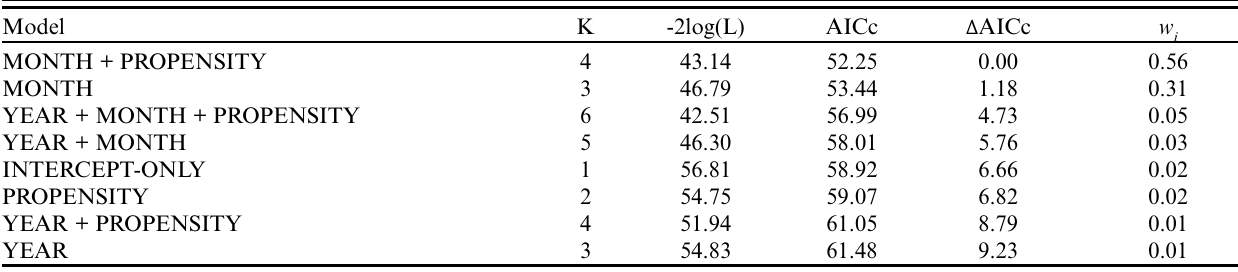
Table 5 . Candidate model set and ranking of models representing associations between the foraging metric PROPENSITY and breeding motivation as well as temporal covariates MONTH and YEAR for Blue-footed Booby ( Sula nebouxii excisa ) nesting sites studied in Galápagos, Ecuador. The number of parameters (K) in each model, the -2 log likelihoods (-2log(L)), and small sample size-corrected AIC values (AICc) are shown. The models are ranked by their AICc differences ( Δ AICc ) relative to the best model in the set and the Akaike weights (wi) reflect the probability that a model is the best model in the set.